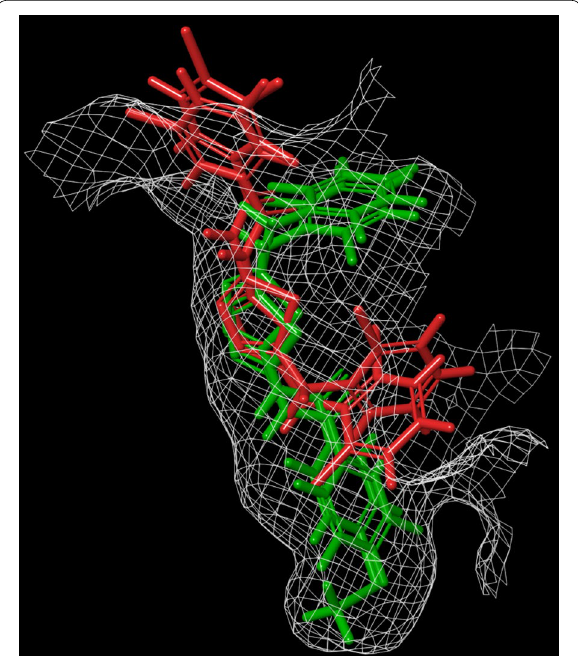
Fig. 5 Alignment of the binding conformations of the compounds 7c , 7h (green) and 6d , 6i (red). (Figure generated using Schrodinger’s Maestro module)